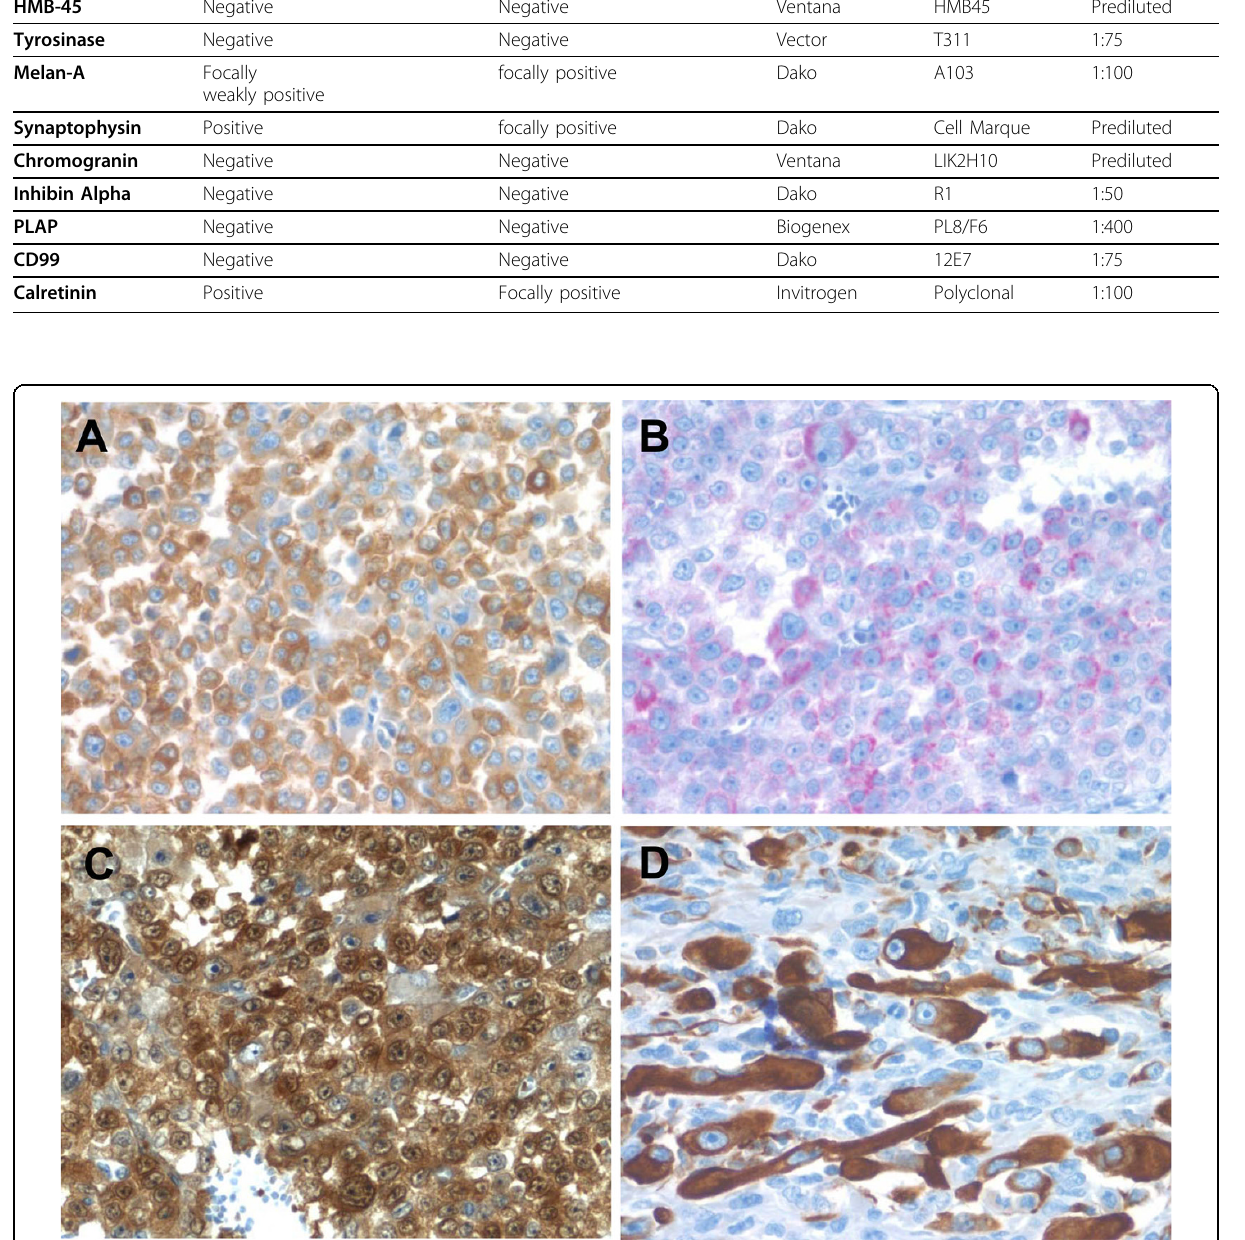
Figure 4 Adrenocortical carcinosarcoma immunohistochemistry . A. The carcinomatous areas are strongly positive for synaptophysin (40×). B. Melan-A shows patchy positivity in the carcinomatous areas (40×). C. Calretinin immunostain showing diffuse cytoplasmic and nuclear positivity in carcinomatous areas (40×). D. Desmin immunostaining highlighting rhabomyoblastic cells in sarcomatous area